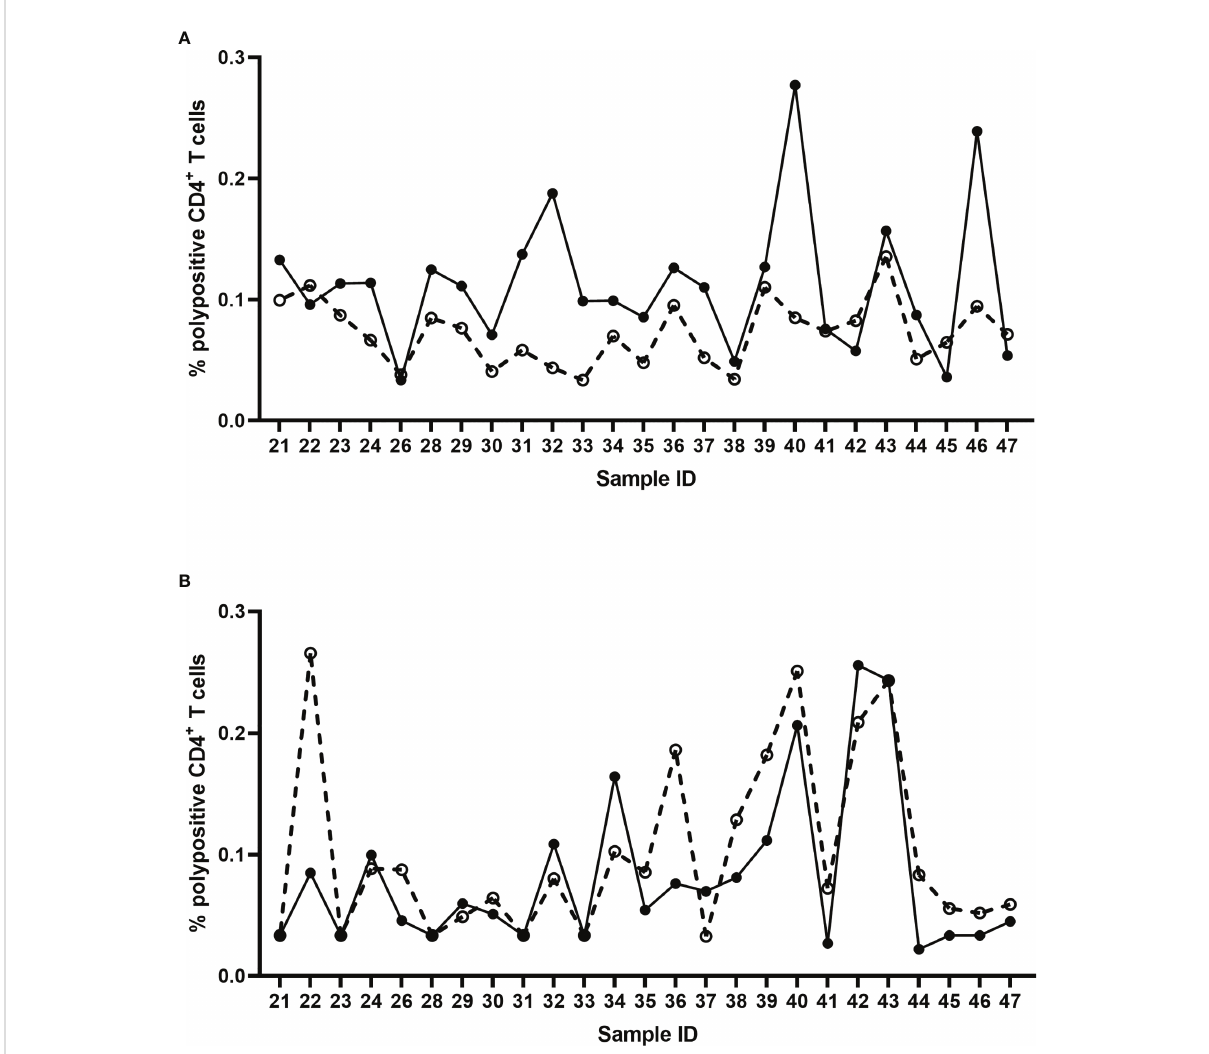
FIGURE 7 Percentage of corrected A/California/07/2009-speci fi c (A) and non-speci fi c (ATT) (B) polypositive CD4 + T cells before (dashed line) and 7 days after (solid line) seasonal in fl uenza vaccination in 25 individual donors. Each data point represents an individual background-corrected result either pre- (open dots) or post- (closed dots) vaccination, reported as a percent of polypositive CD4 + T